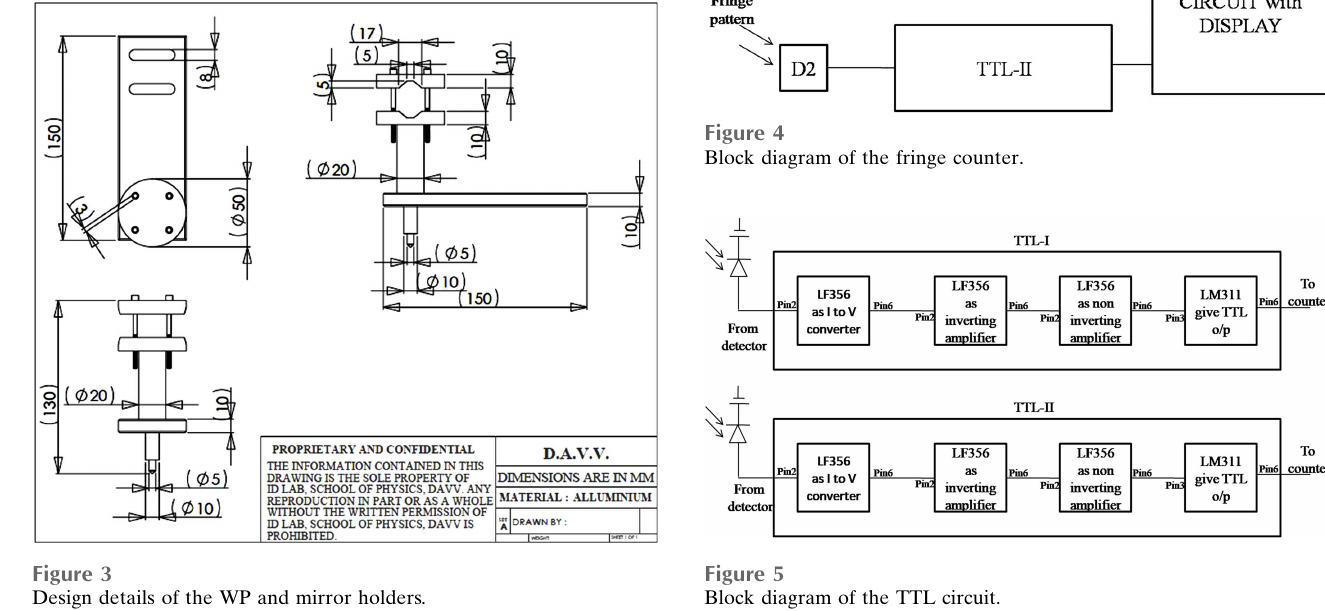
Figure 3 Design details of the WP and mirror holders.